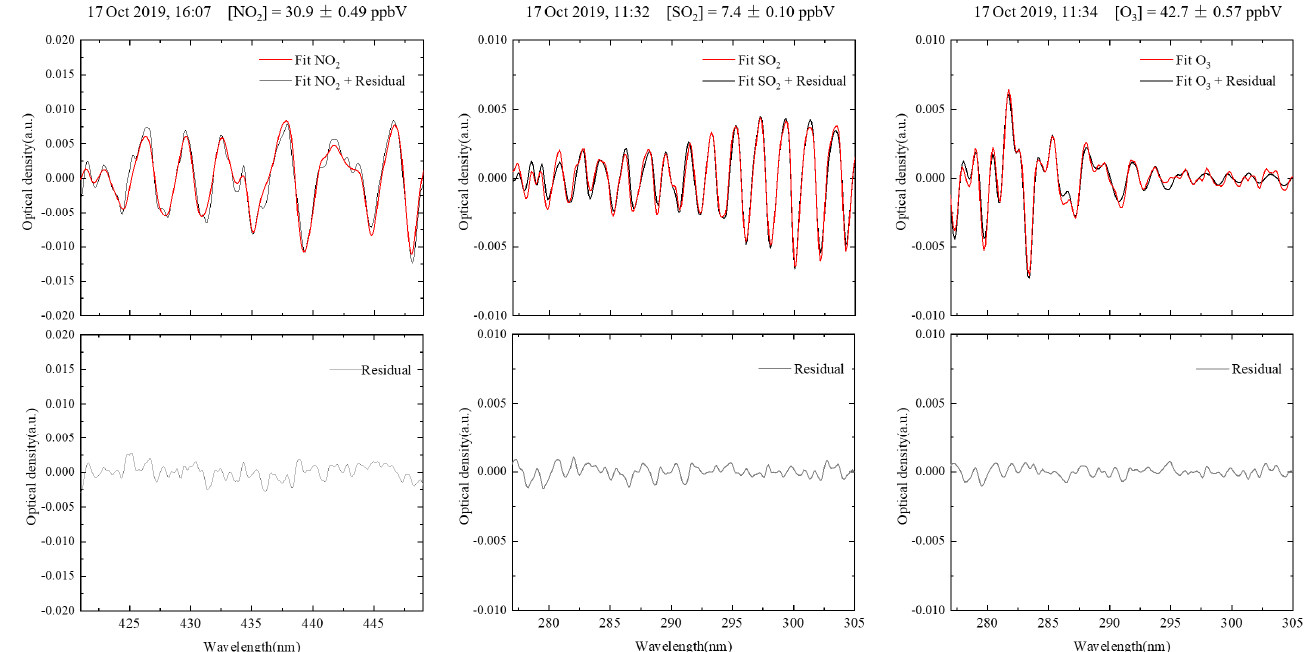
Figure 4. Example of measured (grey line) and fitted absorption spectra (red line) of NO 2 , SO 2 , and O 3 measured on 17 October 2019.